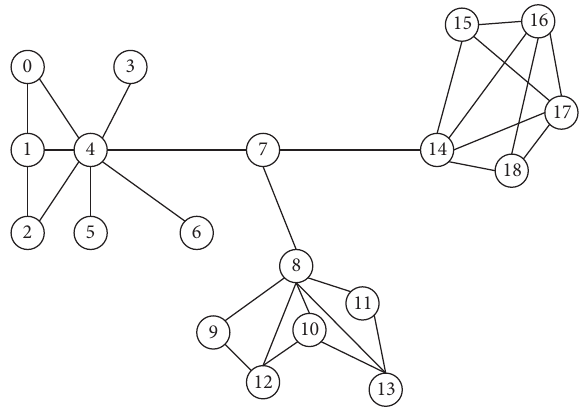
Figure 1: Simple undirected